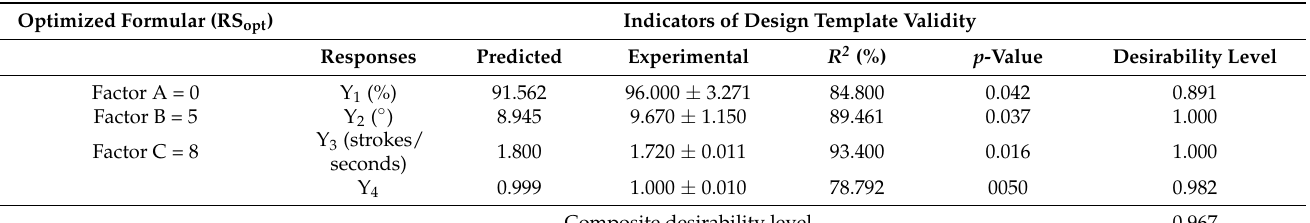
Table 5. Optimized suspension formular and pointers showing experimental design